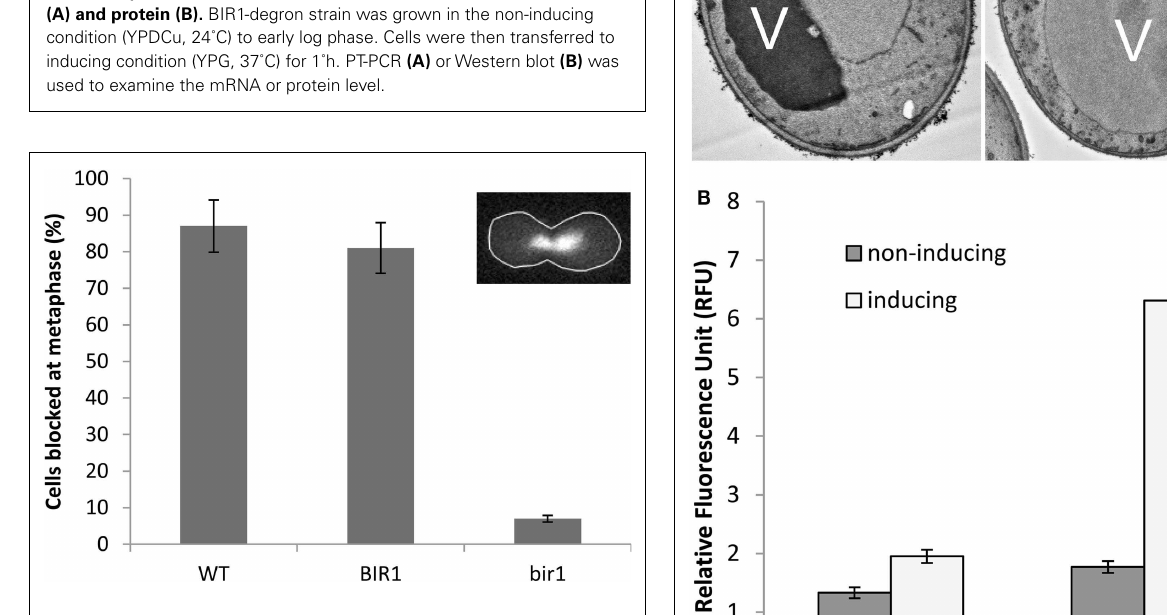
FIGURE 2 | Bir1 deletion causes spindle checkpoint defects. Wild type was grown inYPD at 30˚C (WT), or BIR1-degron strain was grown in either non-inducing condition (YPDCu, 24˚C; BIR1), or in inducing condition (YPG, 37˚C; bir1) to log phase. 10 µ g/ml of nocodazole was added to culture media for 2h. Cells were stained with DAPI and examined using a fluorescence microscope. Cells were considered as metaphase when (1). A cell had a daughter cell similar in size to the mother cell; and (2).The nuclei were in the middle of the dividing cells (inset). About 300 cells were counted from two independent experiments.